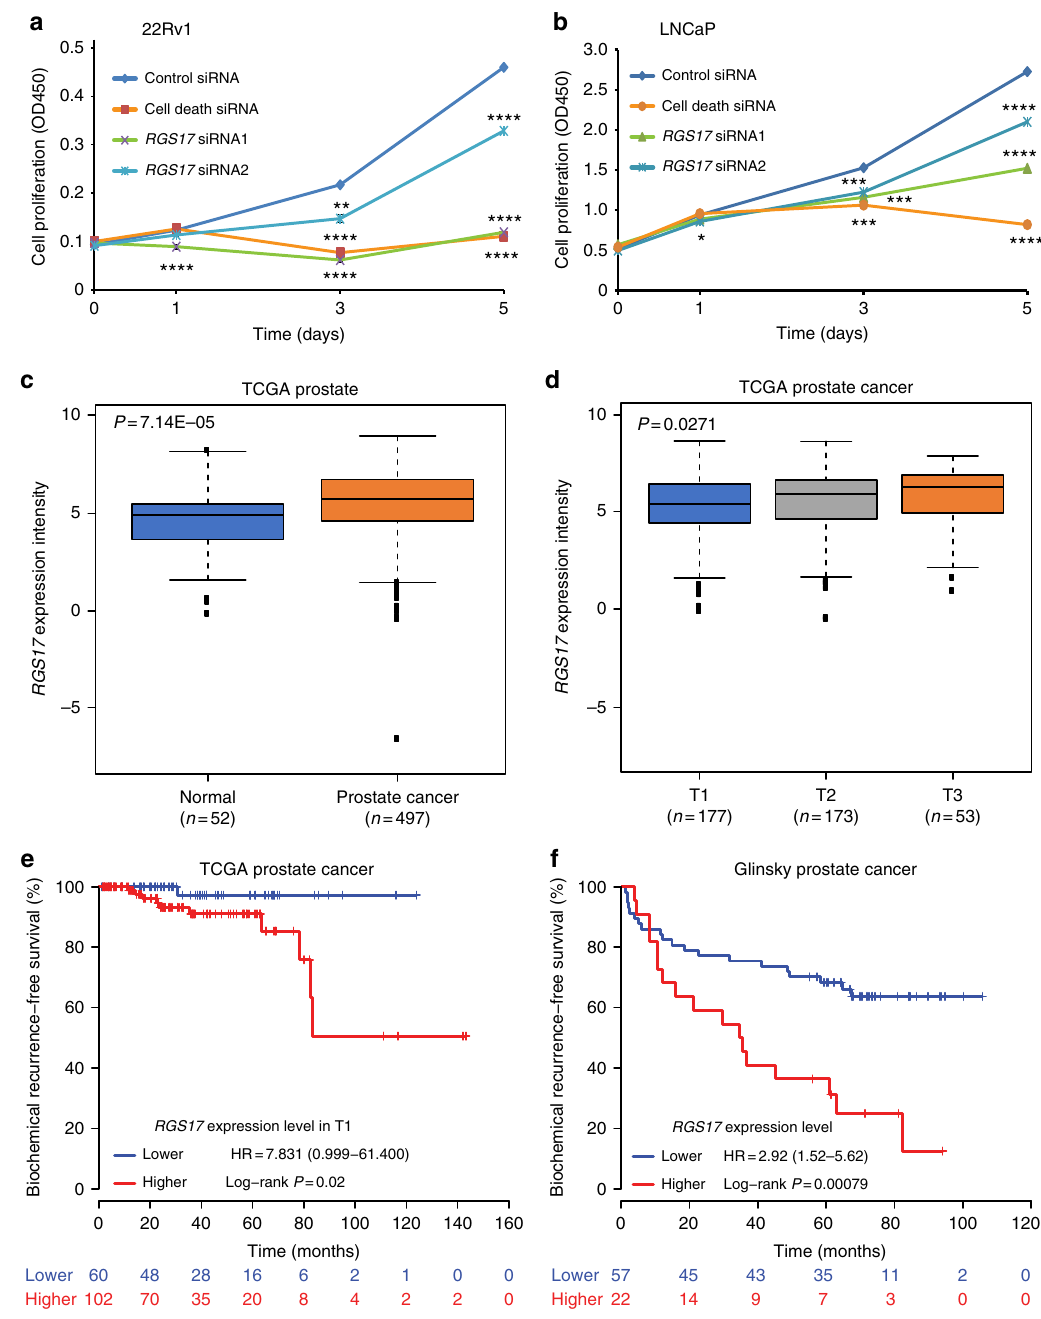
Fig. 6 Association of the rs13215402-associated gene RGS17 with cell growth and clinical features for prostate cancer. a , b Knockdown of RGS17 by siRNA signi fi cantly reduces prostate cancer cell proliferation in 22RV1 and LNCaP cells, measured by XTT colorimetric assay (absorbance at 450 nm, OD450); mean ± s.d. of three independent measurements. ** P < 0.01, *** P < 0.001, **** P < 0.0001, two-tailed Student ’ s t -test. c Expression of RGS17 is higher in prostate adenocarcinoma than in normal prostate gland in TCGA data. d The RGS17 mRNA expression in patients with T3 stage are higher than T2/ T1 stage in TCGA prostate cancer data. In c – d , RGS17 expression intensity is shown as log2 transformed expression value (read per million or RPM by RNA- seq). The upper, middle, and lower bounds of boxes represent the 75th, 50th, and 25th percentile of the values, respectively. The whiskers represent 95th to 5th percentile. Mann – Whitney U -tests ( c ) or Kruskal – Wallis test ( d ) were used to evaluate the statistical signi fi cance. e , f The patients with higher mRNA level of RGS17 have worse recurrence-free survival rate based on TCGA and Glinsky prostate cancer data